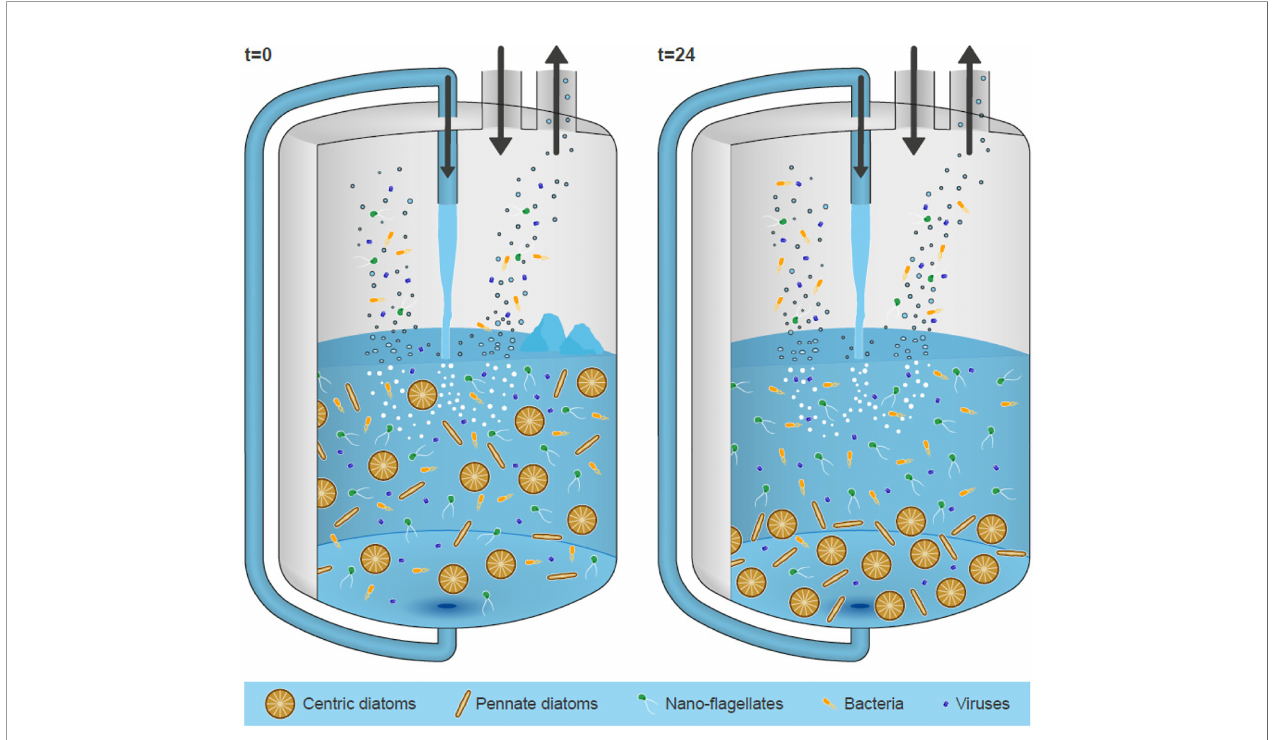
FIGURE 8 | Schematic for the pathways of SSA and their possible relationships with biological processes in seawater. Please note schematic is illustrative, centric diatoms and pennate diatoms are larger (>20 µm, average 80-120 µm) than nano- fl agellates (<20 µm) and bacteria (prokaryotes) (<1 µm) and virus (<0.5